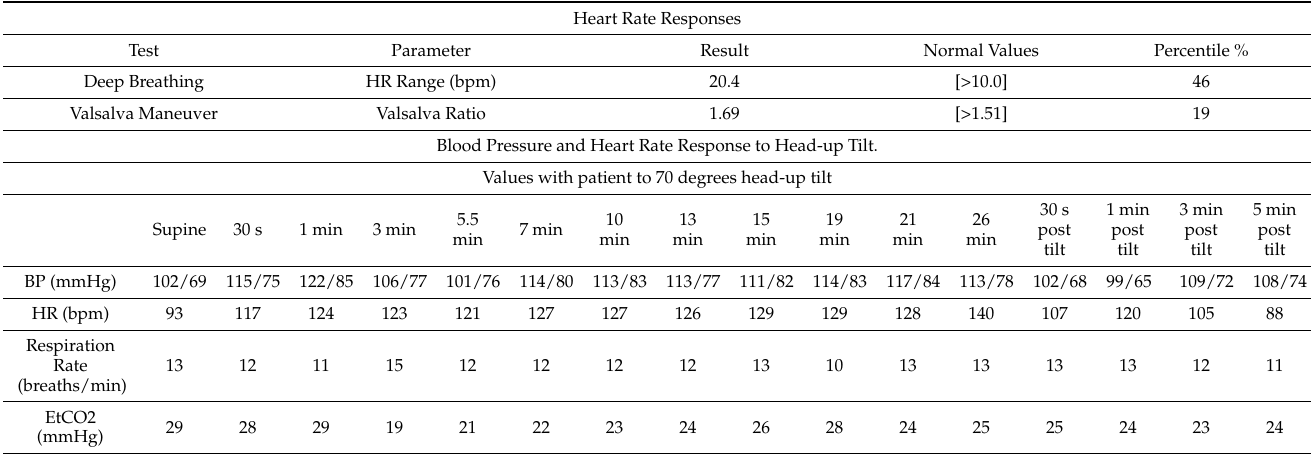
Figure 2. Cardiorespiratory responses from supine to head-up tilt. Table 1. Blood pressure and heart rate response from supine to head-up tilt.